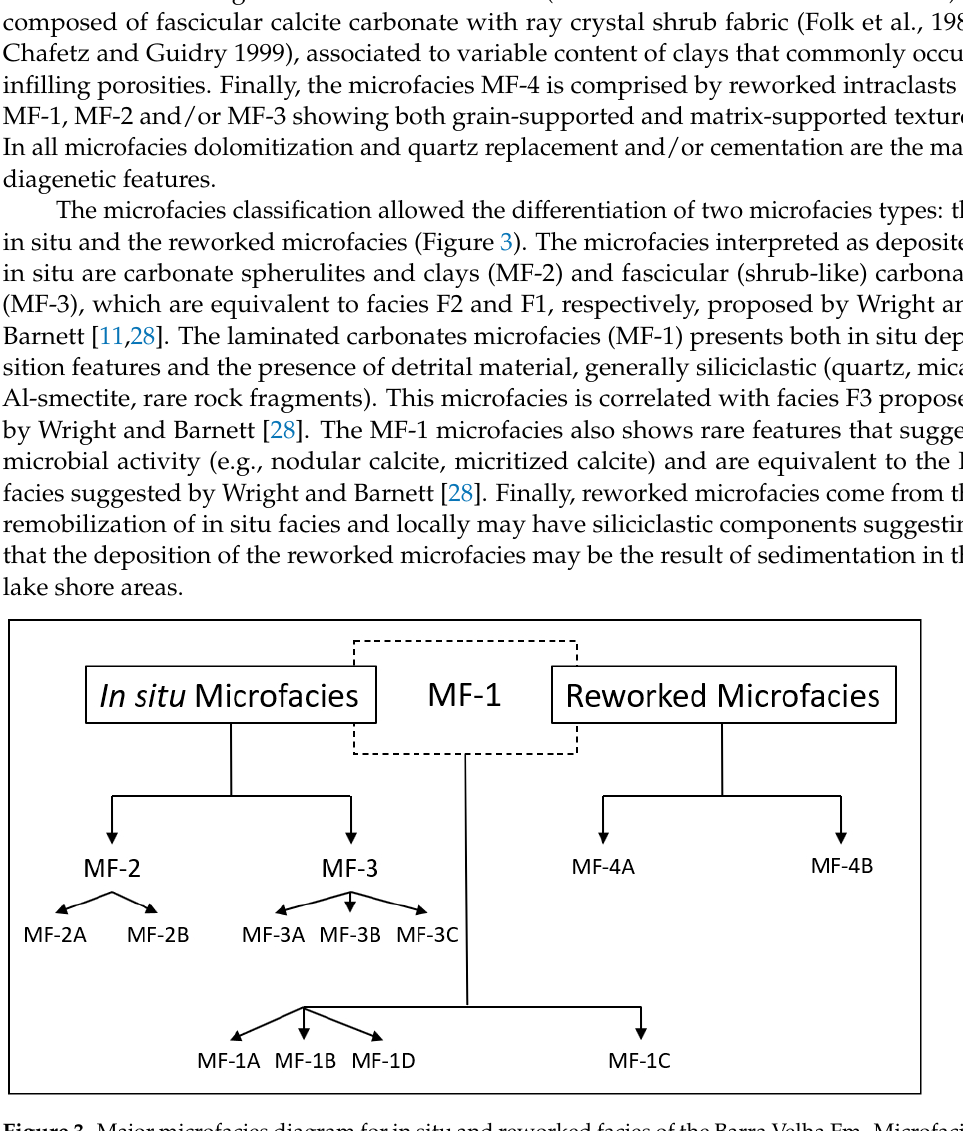
Figure 3. Major microfacies diagram for in situ and reworked facies of the Barra Velha Fm. Microfacies MF-2 and MF-3 are in situ while Mf-4 represents the reworked ones. MF-1 presents both in situ (MF-1A, MF-1B and MF-1D) and mixture of detrital grains, reworked intraclasts and in situ material in the microfacies MF-1C (modified from Wright and Barnett [28]).